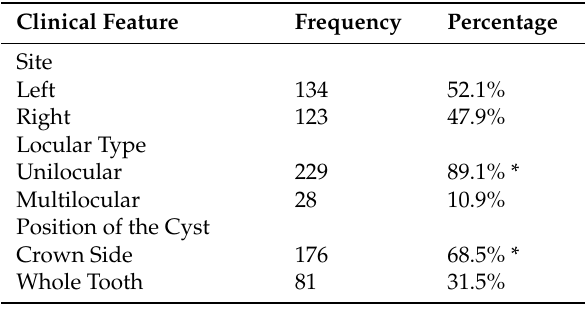
Table 1. The clinical features of dentigerous cysts on panoramic radiographs.